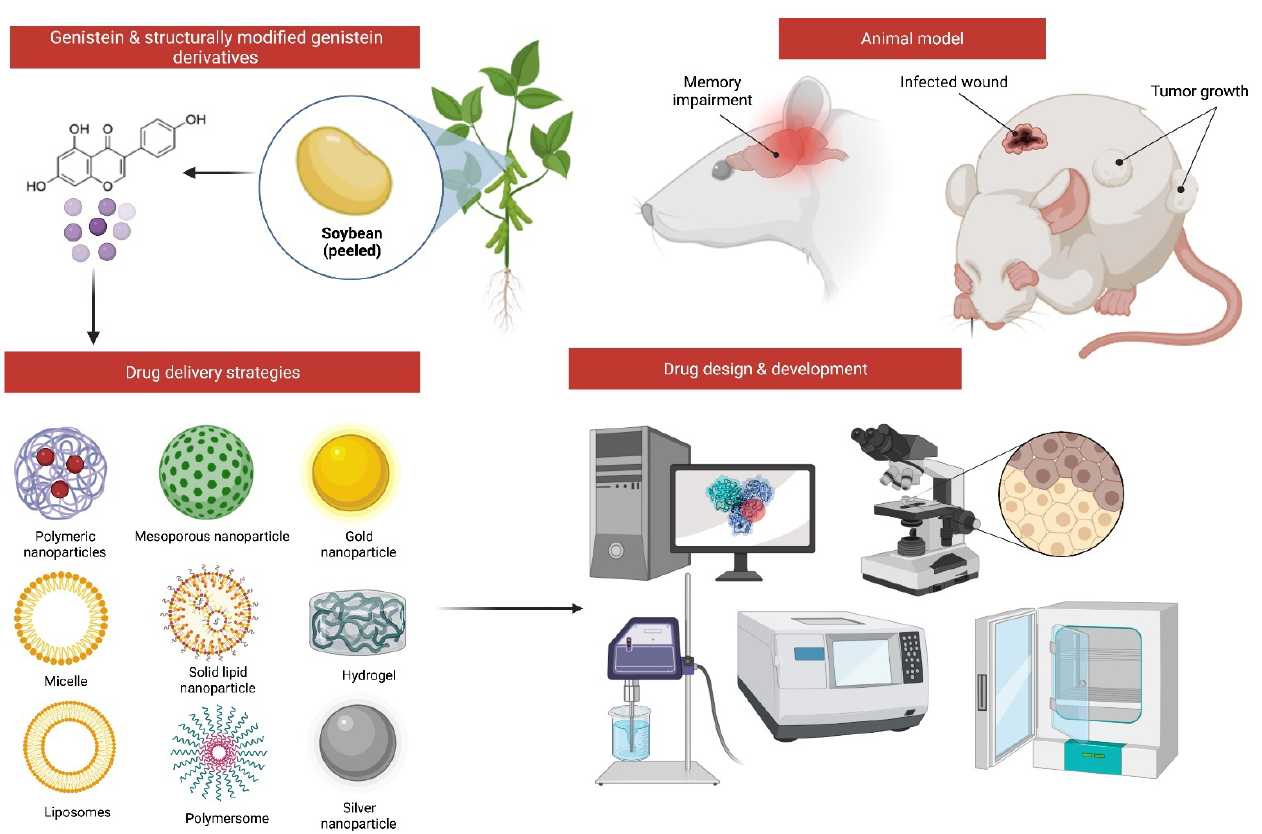
Figure 7. Incorporating structurally modified genistein into a drug delivery system may increase drug delivery to the brain and other targeted areas.